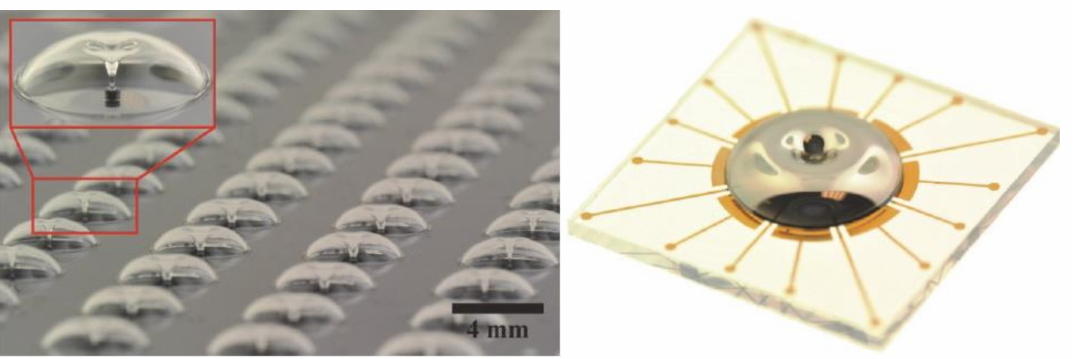
Figure 11. Image showing wafer-scale glassblowing can enable true batch micro-glassblowing fabrication process and final fabricated FS resonator with out-of-plane electrodes (Senkal et al. [92]) Reprinted from ref [92], © (2022), with permission from Elsevier.